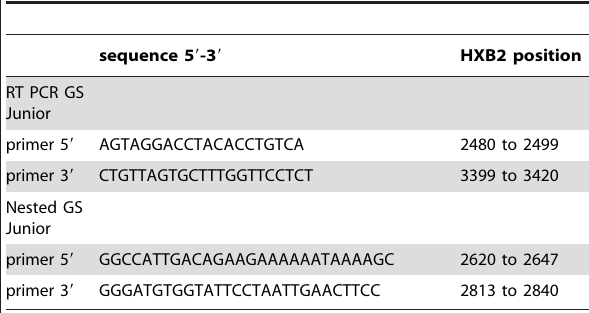
Table 1. Primers used for GS Junior ultradeep sequencing of RT.